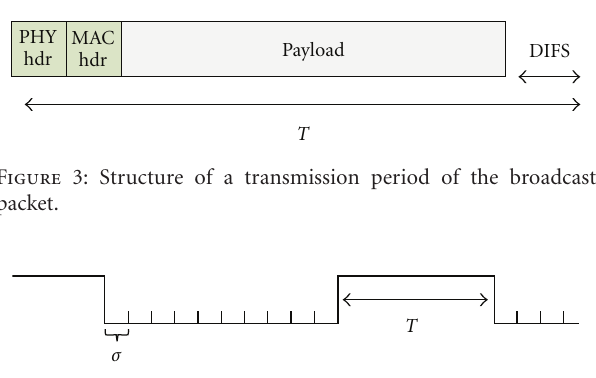
Figure 4: The idle duration consists of several consecutive idle